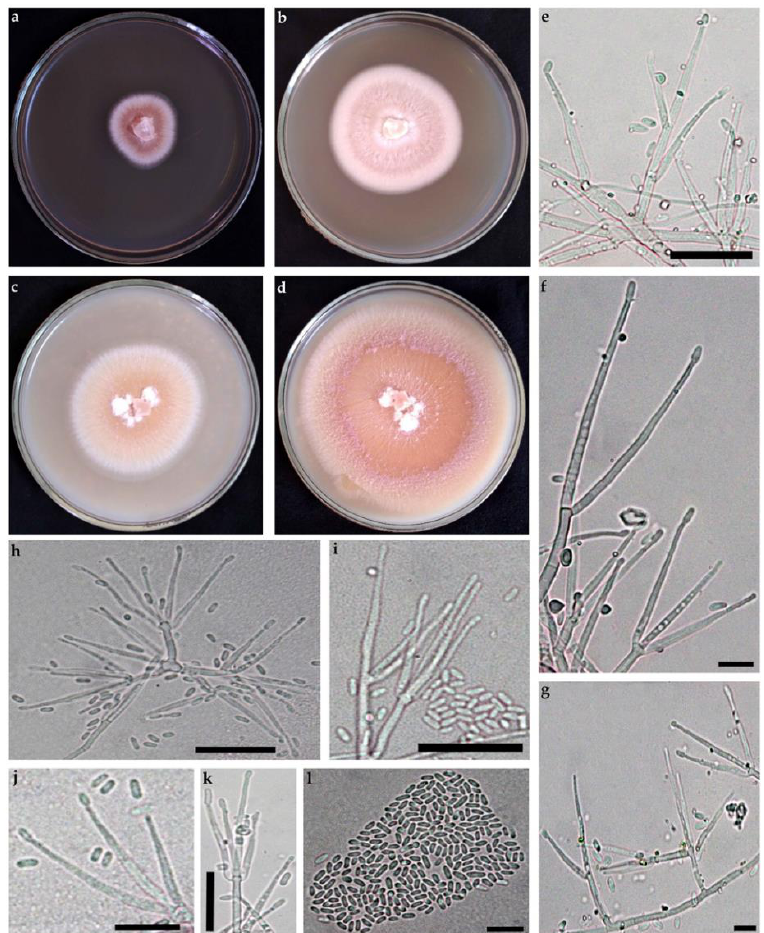
Figure 4. Sarocladium pseudokiliense (IRAN 3649C). colony after 7 ( a ) and 14 ( b ) days of incubation on PDA; colony after 7 ( c ) and 14 ( d ) days of incubation on OA; ( e – k ) conidiophores, phialides, and conidia; and ( l ) conidia. Scales bars ( e – k ) 20 µ m and ( j , l ) 10 µ